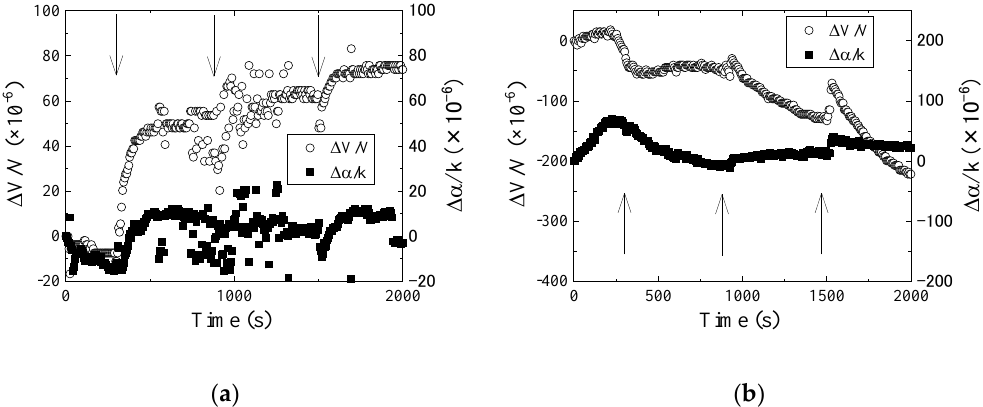
Figure 5. Measured results of ( a ) iron and ( b ) carbon powders in new engine oil obtained from Ch.1. The arrow indicates the addition time of the particles of 0.5 mg.